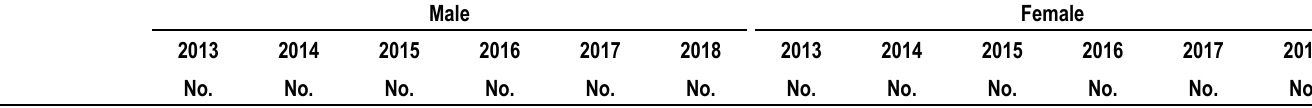
Table 8a. Diagnoses of HIV infection attributed to injection drug use, by selected characteristics, 2013–2018—United